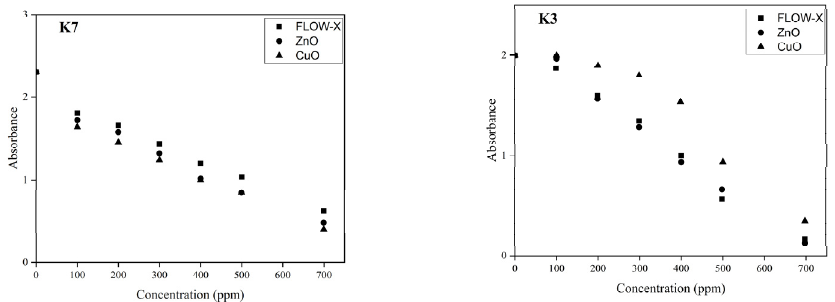
Figure 11. Asphaltene Adsorption by UV–Vis left (K3) right (K7).